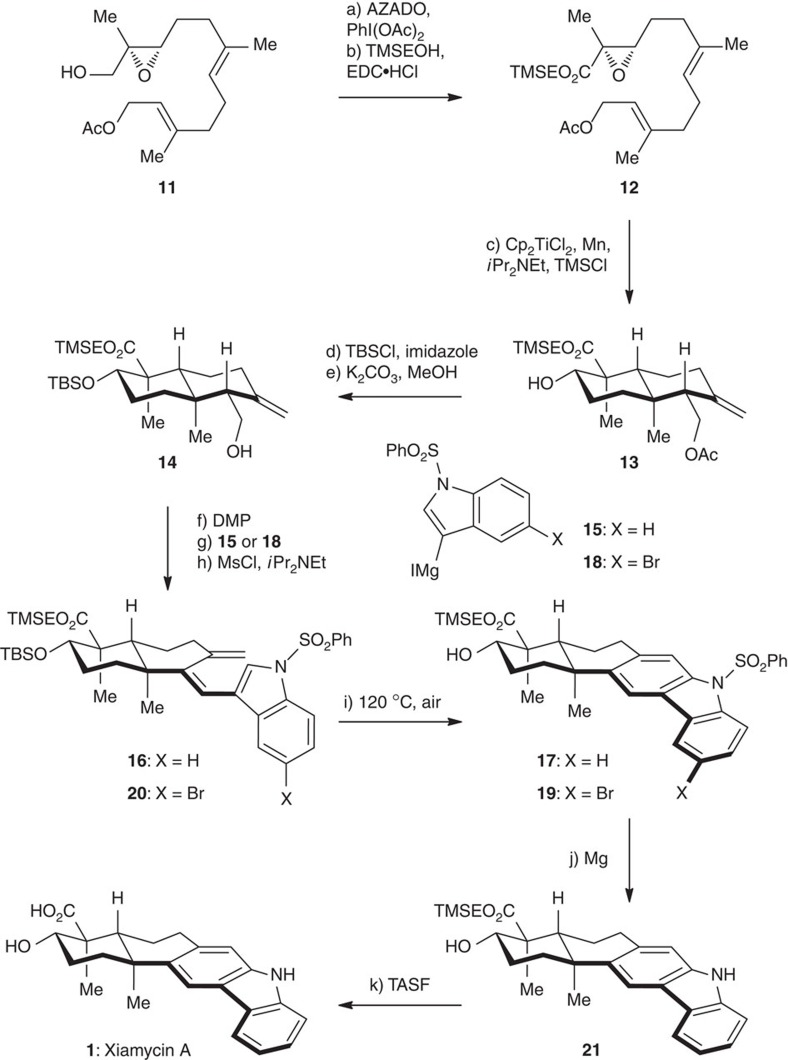
The 6π-electrocyclization/aromatization approach towards the total synthesis of xiamycin A.Reagents and conditions: (a) AZADO (5 mol%), PhI(OAc)2 (3.0 eq), CH2Cl2, 22 °C, 6 h; (b) TMSEOH (1.2 eq), EDC·HCl (1.1 eq), 4-DMAP (1.0 eq), CH2Cl2, 22 °C, 5 h, 76% (two steps); (c) Cp2TiCl2 (20 mol%), Mn (8.0 eq), iPr2NEt (6.0 eq), TMSCl (5.0 eq), THF, 22 °C, 4 h; (d) TBSCl (1.2 eq), imidazole (1.5 eq), DMF, 22 °C, 10 h; (e) K2CO3 (1.0 eq), MeOH, 22 °C, 3 h, 44% (3 steps); (f) DMP (1.5 eq), CH2Cl2, 22 °C, 30 min; (g) 15 or 18 (3.0 eq), THF, 22 °C, 40 min; (h) MsCl (1.2 eq), iPr2NEt (1.5 eq), CH2Cl2, 0 °C, 1 h, 75% for 16 (three steps), 71% for 20 (three steps); (i) air, DMSO, 120 °C, 2 h, 80% for 17, 76% for 19; (j) Mg (2.0 eq), MeOH, 22 °C, 1 h, 98%; (k) TASF (2.0 eq), DMF, 50 °C, 95%.